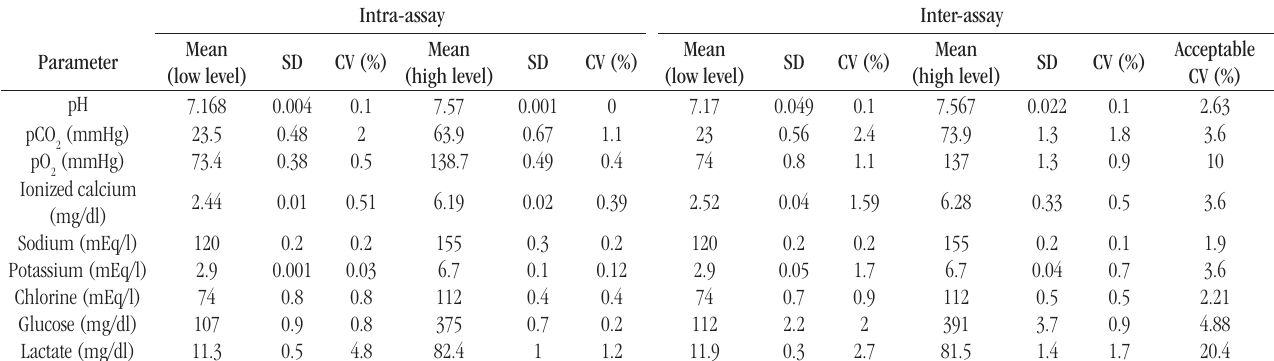
taBLE 1 − Results obtained for assessment of intra- ( n = 40) and inter-assay ( n = 40) precision of blood gas analyzers Intra-assay Inter-assay